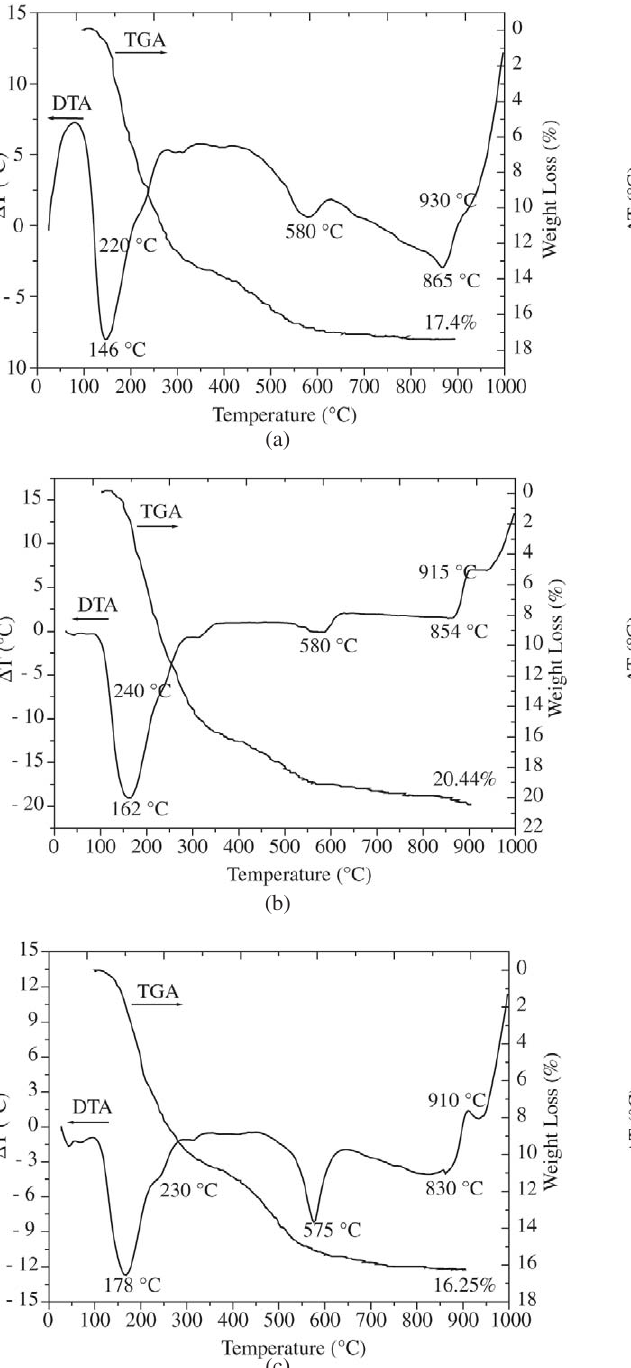
Figure 2. Differential thermal analysis and thermogravimetric curves for the bentonites: a) Bofe ; b) Chocolate ; c) Verde-lodo ; d) Dolomil ; e) Brasgel; f) Brasgel PA